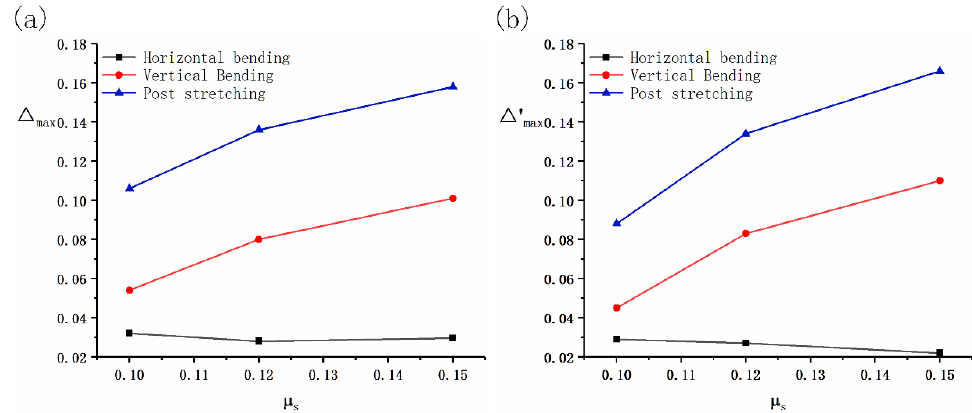
Figure 5. Effect of friction coefficient on thinning. ( a ) Outer web. ( b ) Inner web.